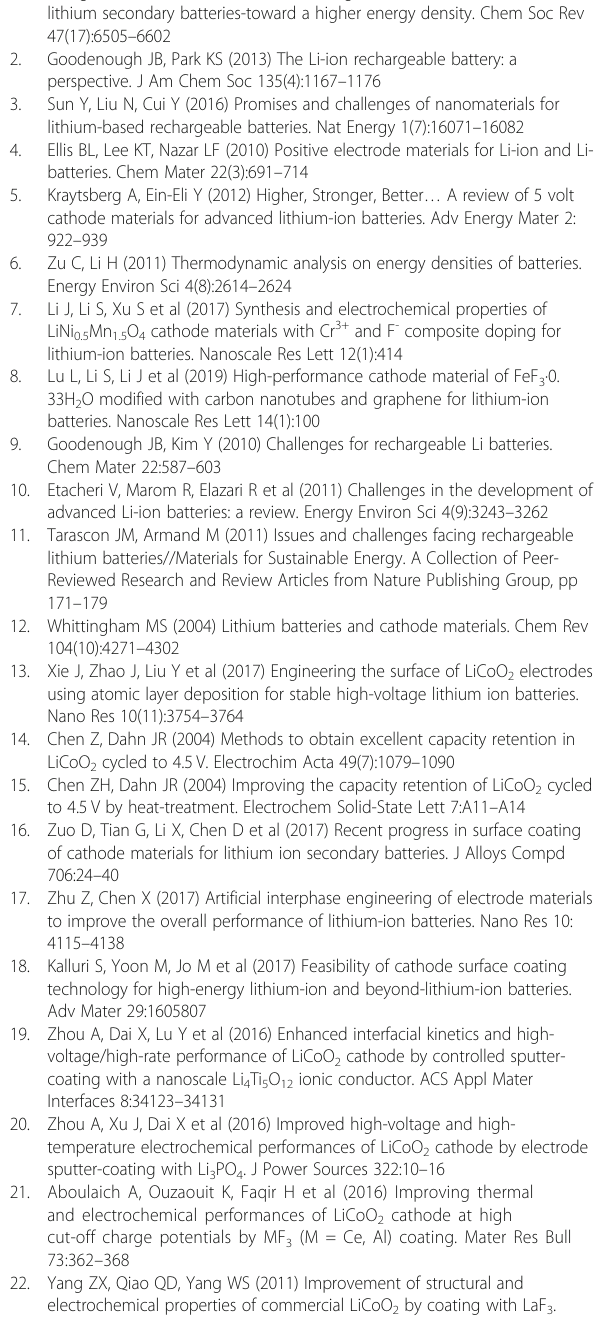
Additional file 1: Figure S1. The thickness of the LLTO thin films with the different deposition time. Figure S2. Electrochemical impedance spectra of the as-assembled testing cells with LCO-LLTO-10, LCO-LLTO-30, LCO-LLTO-60, and LCO-LLTO-100. Figure S3. O 1s spectrum of LCO- LLTO-10 after 100